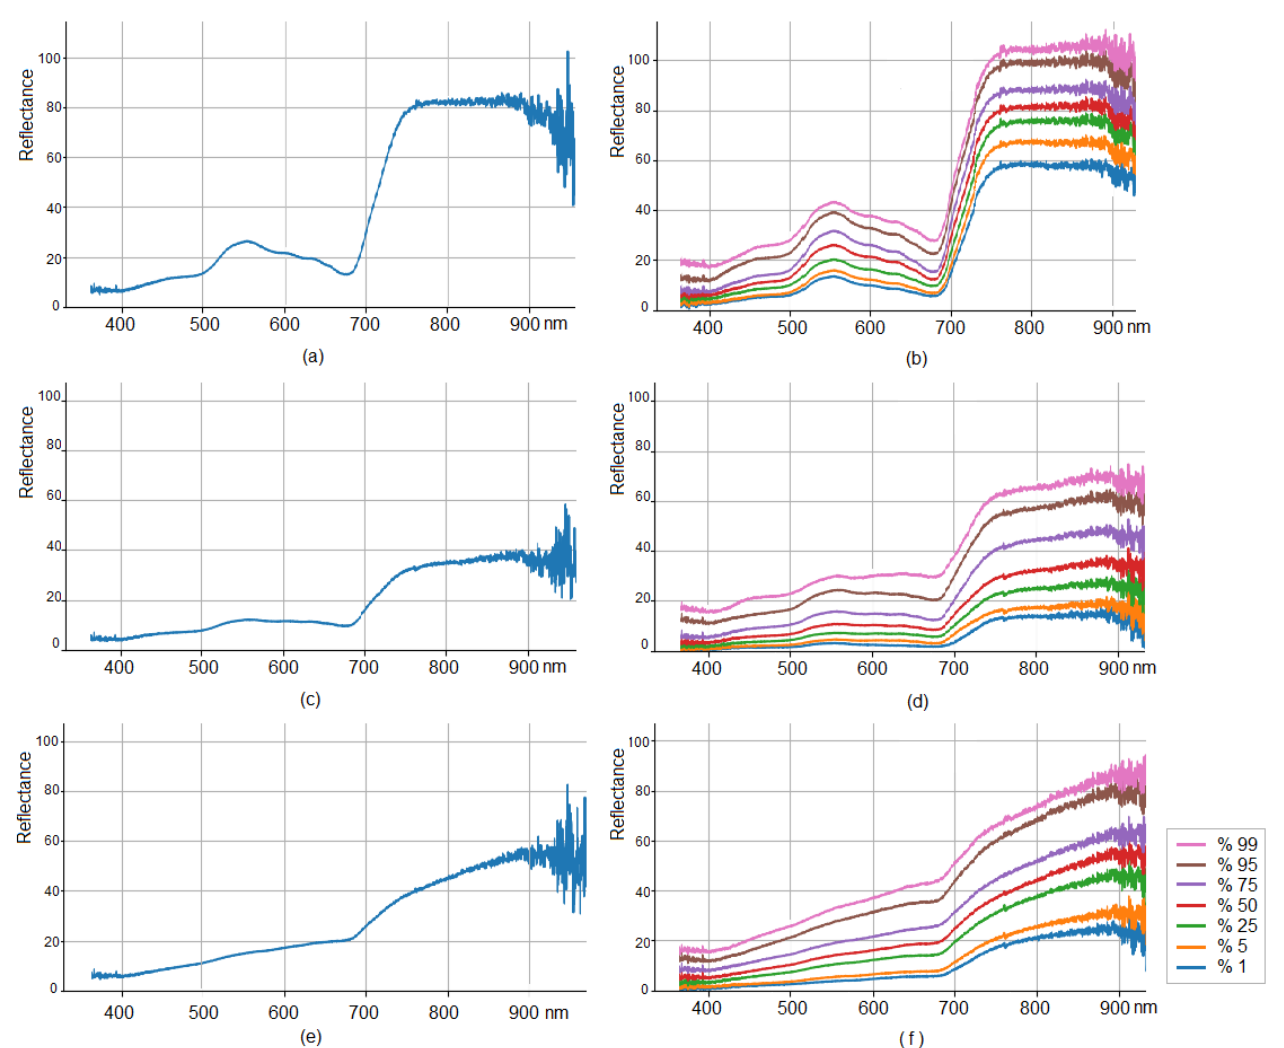
Figure 6. Dataset means and quantiles of variety of hyperspectral curves of ears: ( a , c , e ) — means of healthy, medium-damaged and severely damaged ears, respectively; ( b , d , f ) quantile distribution of the same datasets.